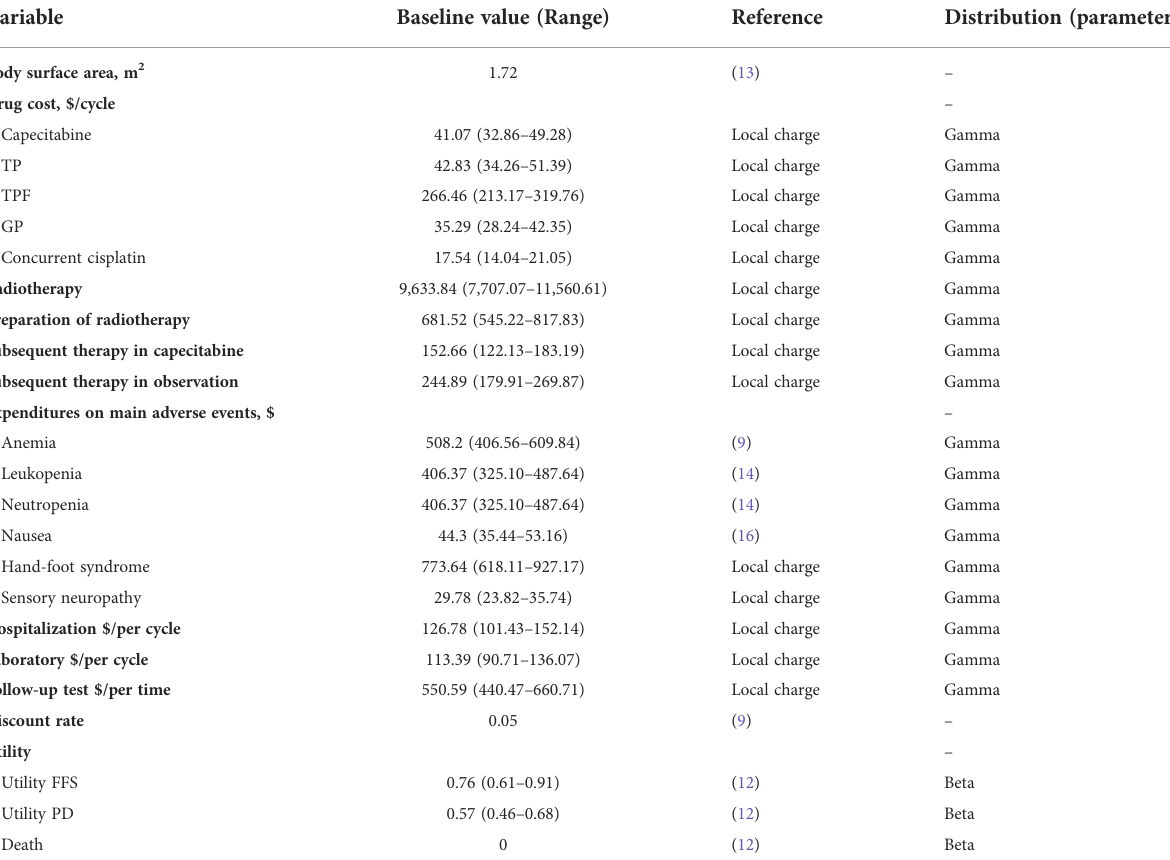
TABLE 2 Cost estimates and utilities.